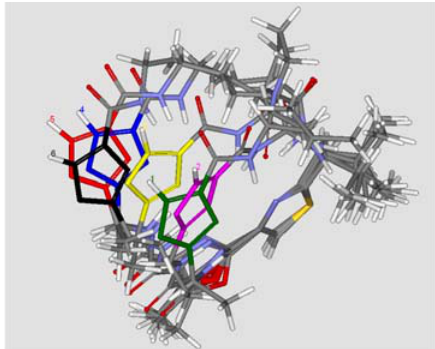
Figure 3. Alignment of compounds 1 – 6 and the oxazole rings (C) of compounds 1 – 6 are depicted in different colors.